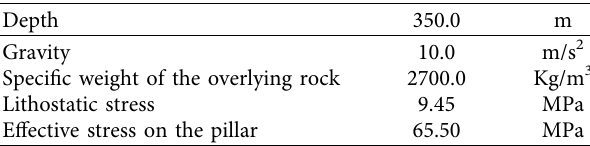
Table 4: Lithostatic stress and pillar-induced